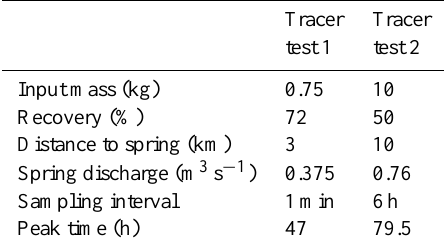
Table 2. Field data of the simulated tracer